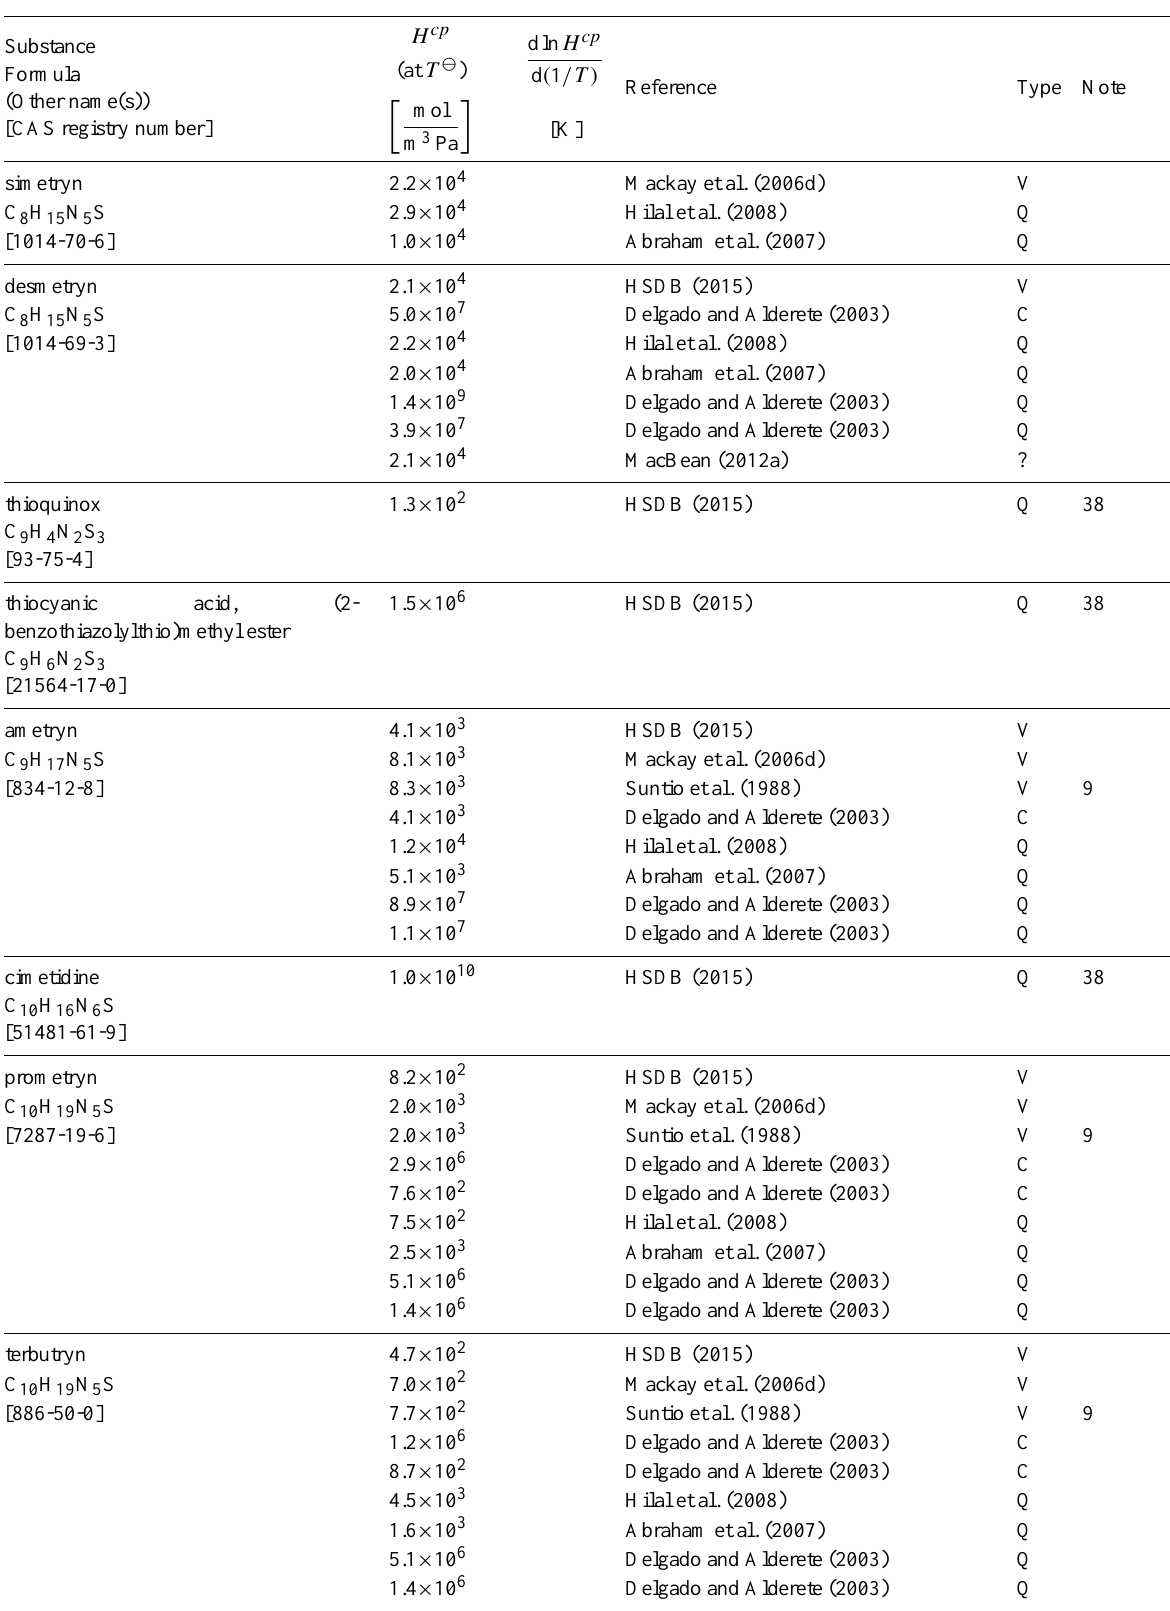
Table 6: Henry’s law constants for water as solvent